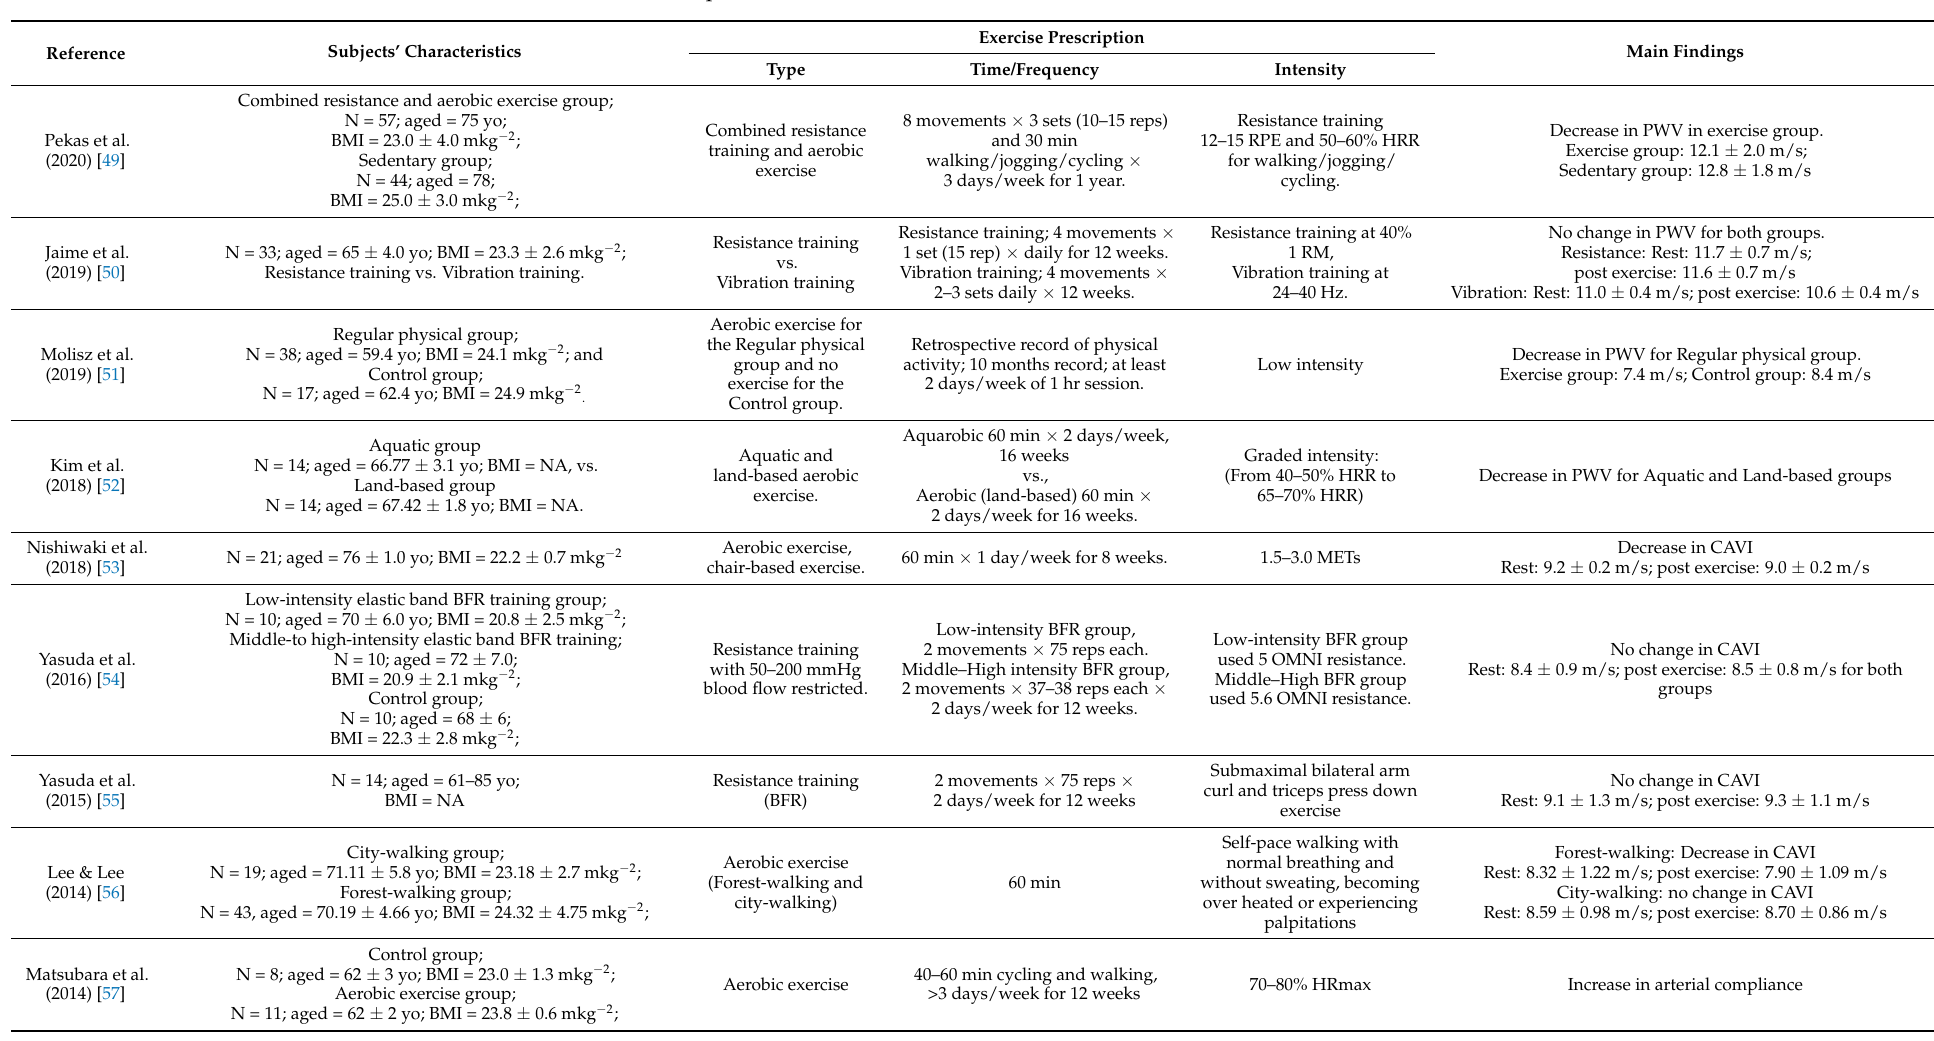
Table 4. Characteristics of selected experimental trials in old women (n =